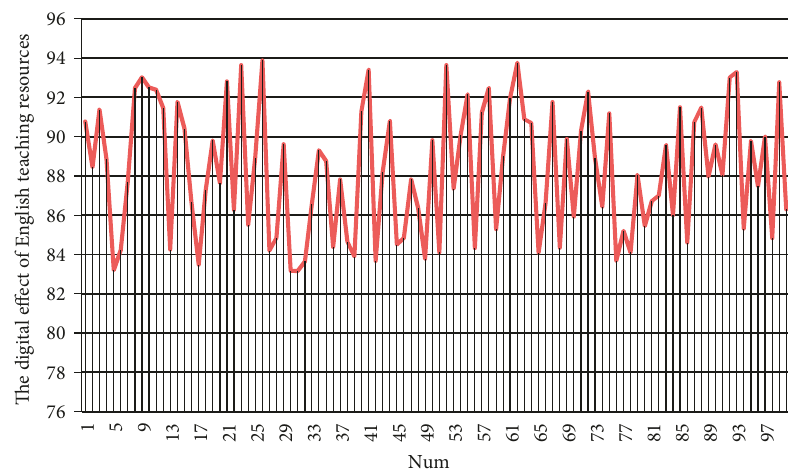
Figure 15: Digital effect of English teaching